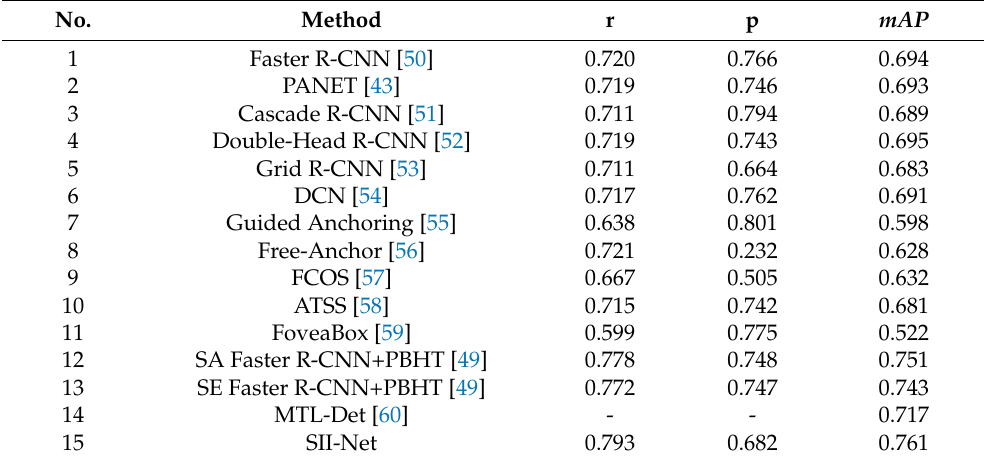
Table 1. Evaluation indices comparison with the other methods on LS-SSDD-v1.0 of the entire scenes. No. Method r